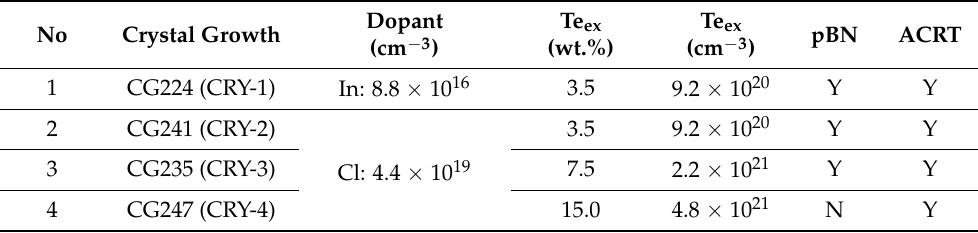
Table 1. Growth description for all CdTe crystal